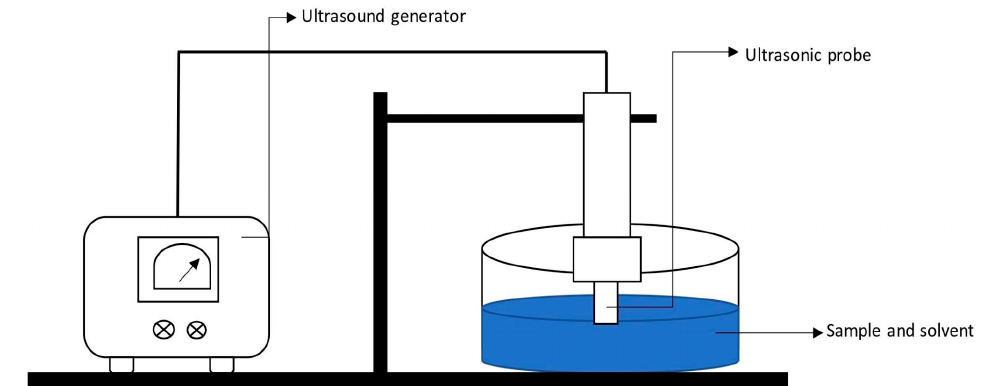
Figure 8. A diagrammatic representation of ultrasound-assisted extraction.